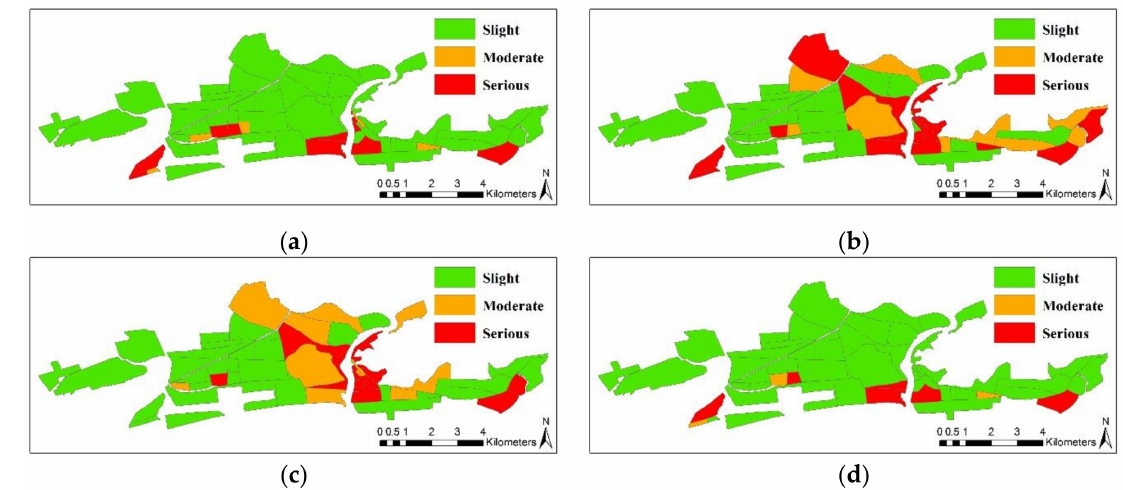
Figure 30. Block-level reference map and damage maps in Ishinomaki: ( a ) reference map; ( b ) damage map from the H − α − ρ method; ( c ) damage map from the PWMF method; ( d ) damage map from the proposed method.